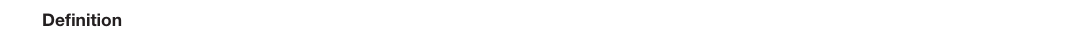
TABLE 1 | Terms and